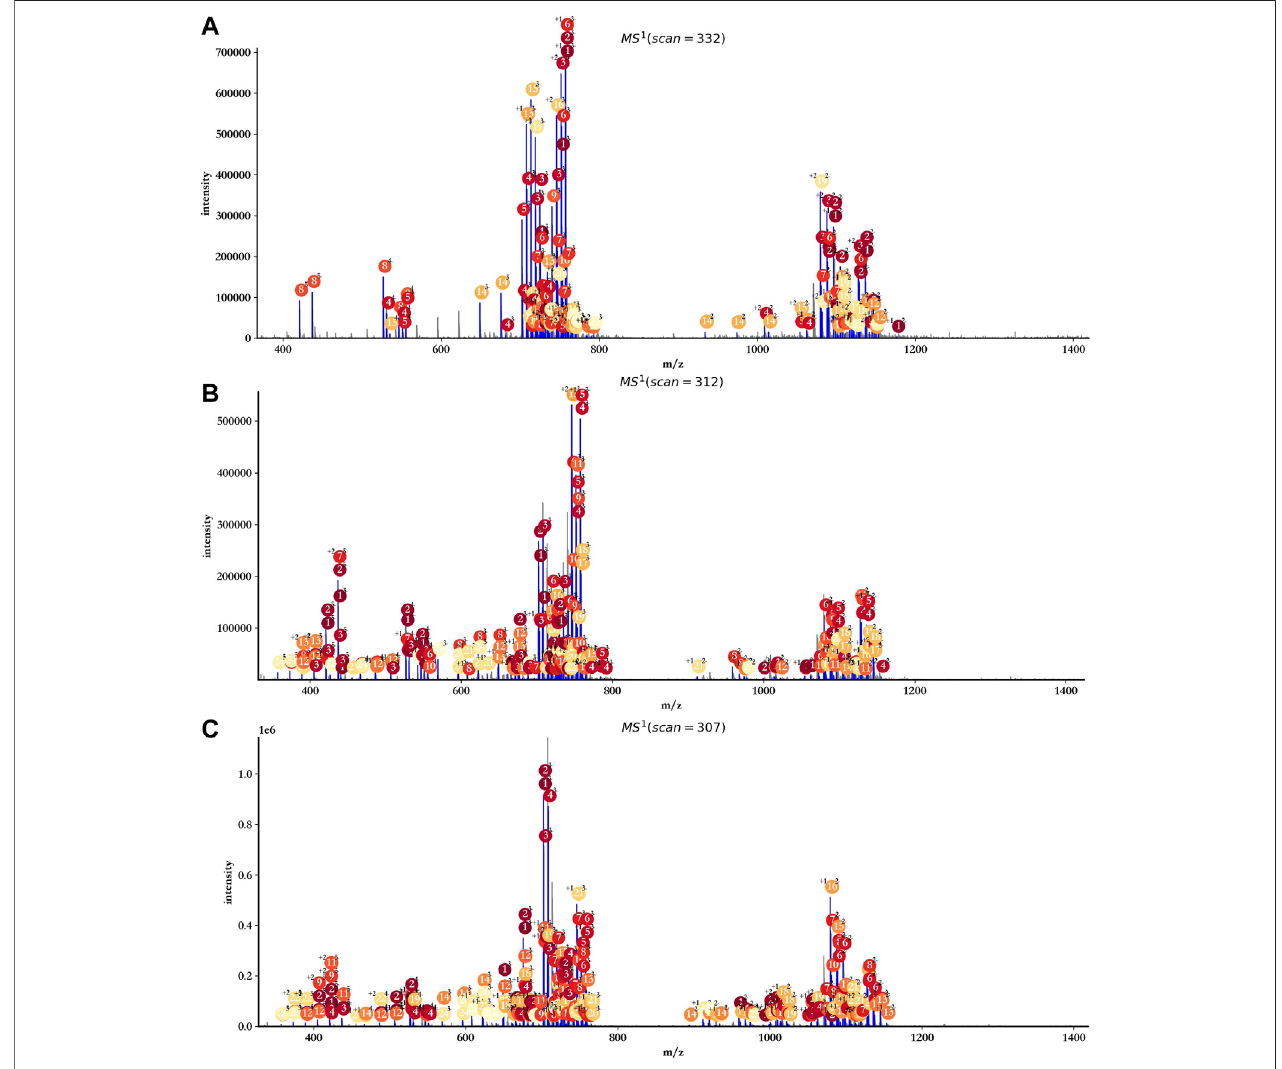
FIGURE 7 | Annotation results of triplicate HS samples using hepParser. (A) hn042408-01.mzML. (B) hn042408-03.mzML. (C) hn042408-06.mzML.